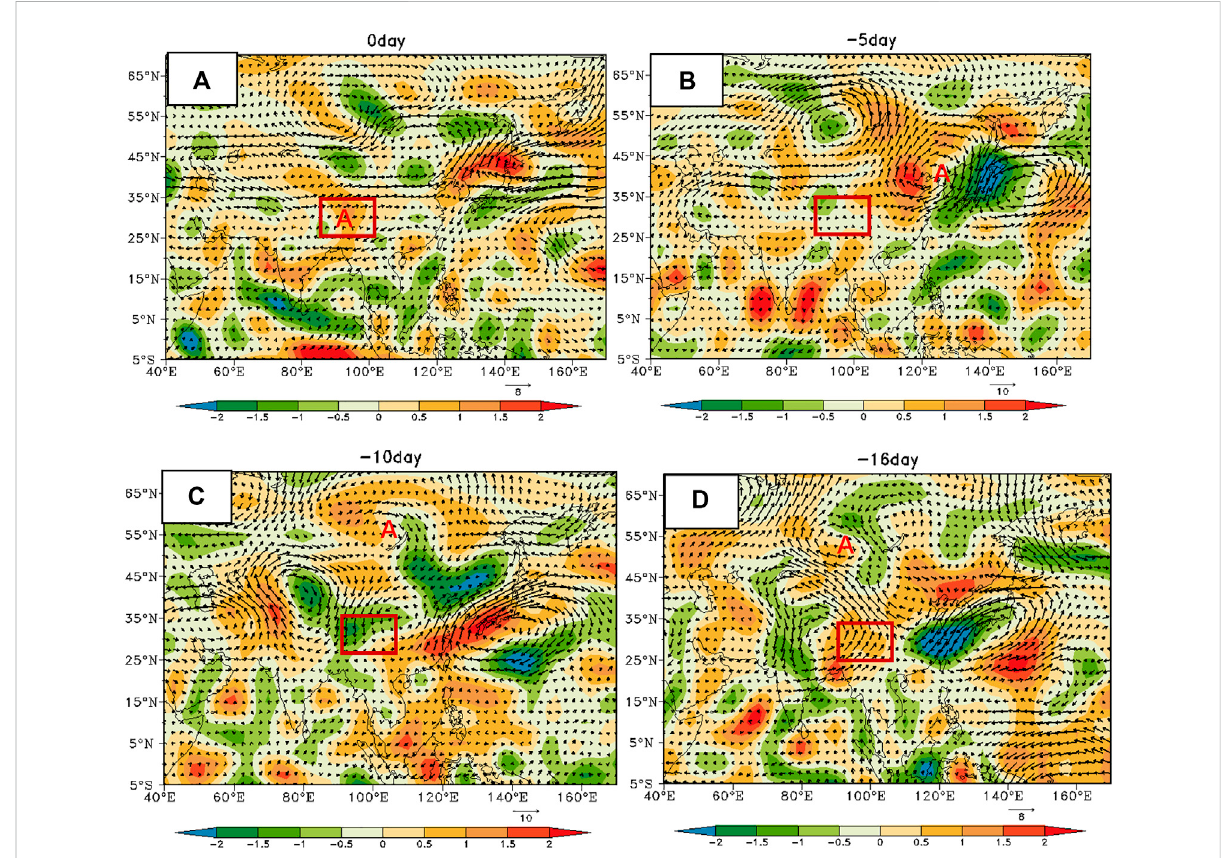
FIGURE 12 Evolution of the low-frequency (15 – 30 days) divergence (shading, unit: 10 − 6 S − 1 ) and wind (vector, unit: m/s) fi eld at 200 hPa from 16 days before the precipitation to 0 day after onset in western Sichuan, the red box is the western Sichuan area, and A is the low-frequency